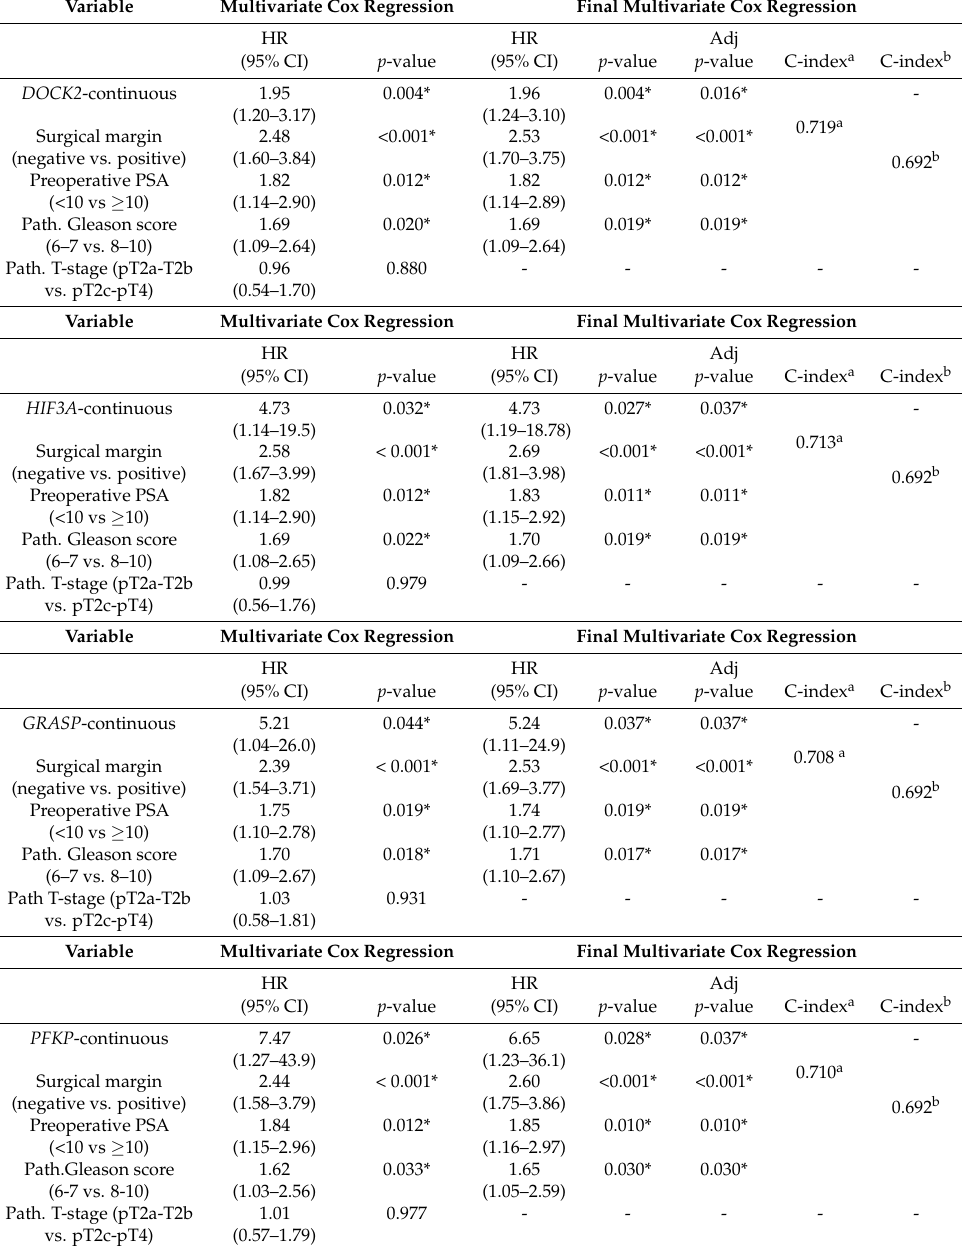
Table 3. Multivariate Cox regression analysis with biochemical recurrence (BCR) as an endpoint. The Danish RP cohort included 234 patients in